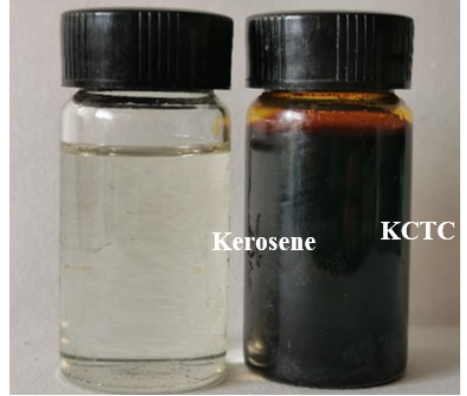
Figure 3. Collectors used in molybdenite flotation.